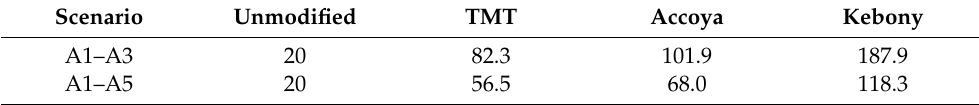
Table 5. Calculated payback times based upon average GWP values for each product